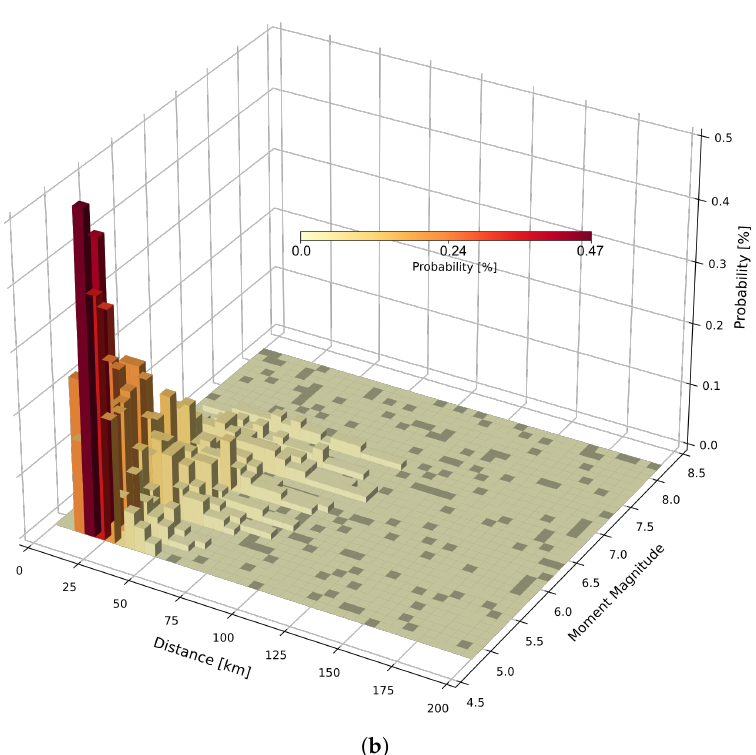
Figure A4. Disaggregation of the seismic hazard for offshore sites in Gujurat at return periods